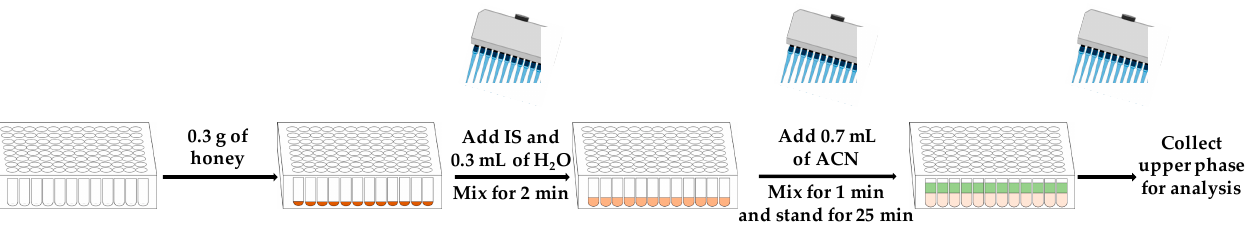
Figure 1. Schematic presentation of high-throughput field matrix-induced sugaring-out.